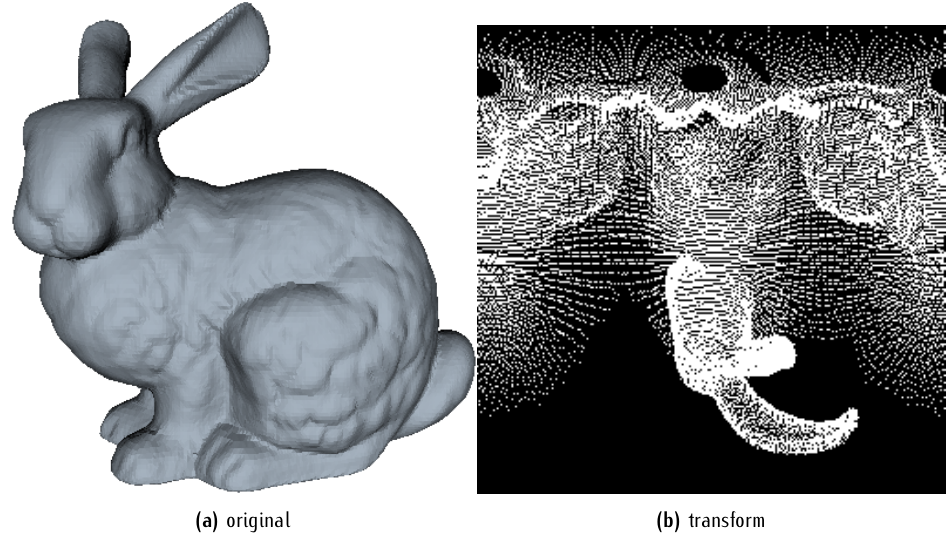
Figure 3. The Spherical Map